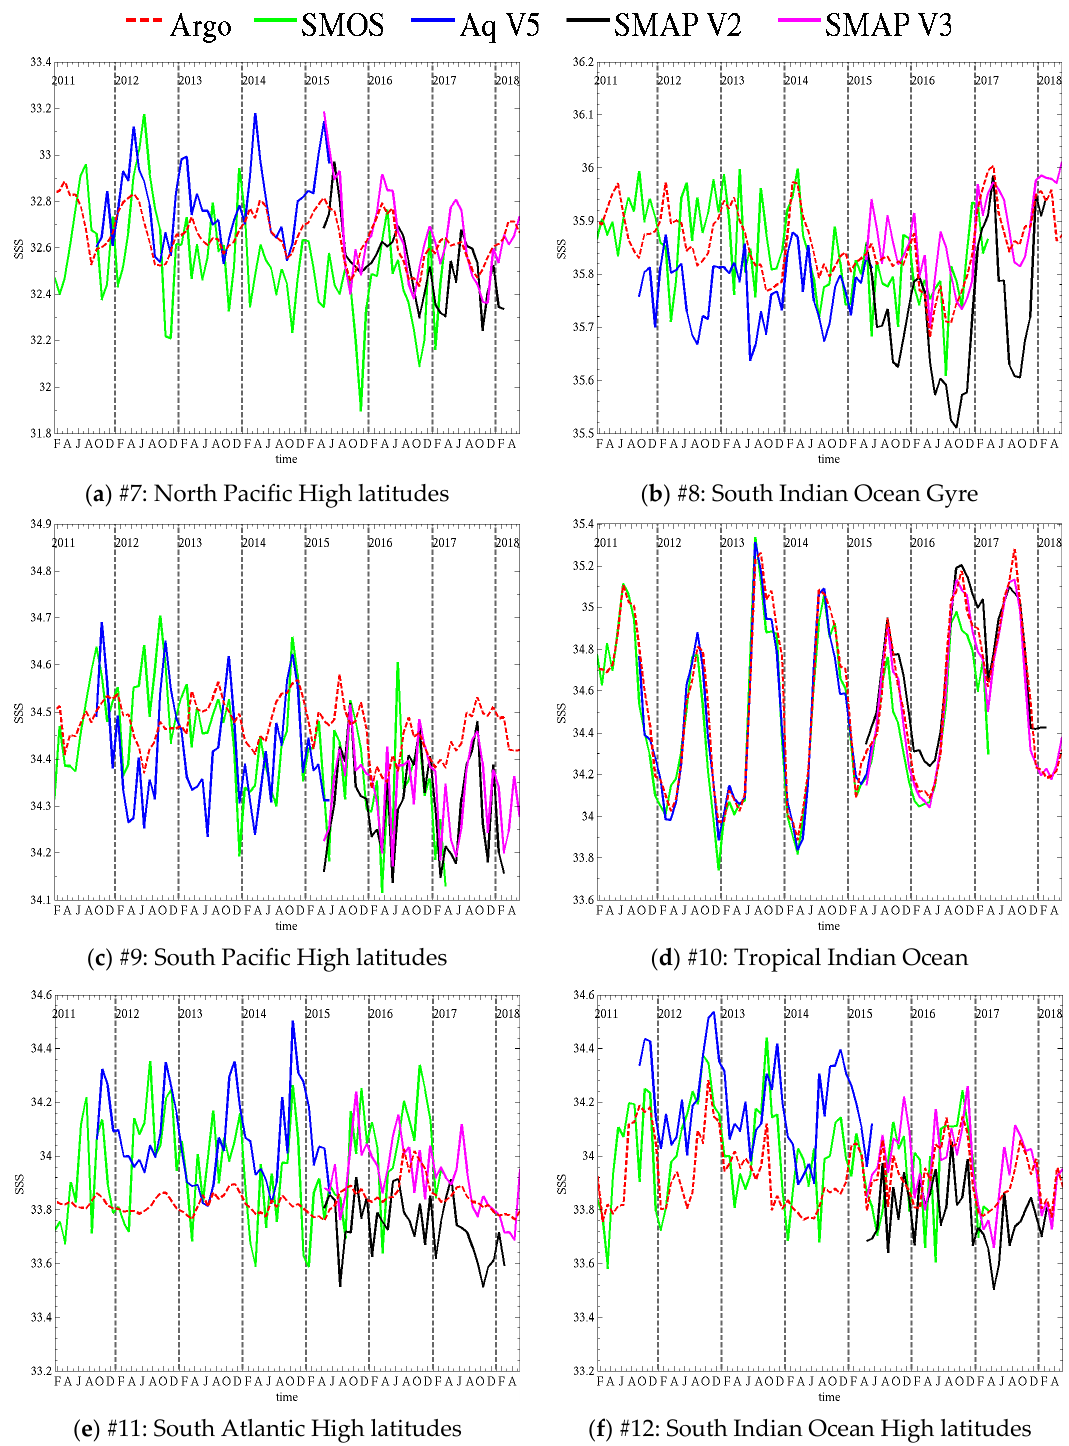
Figure 12. Time series of SSS from (red) Argo, (green) SMOS, (blue) Aquarius and (black) SMAP for regions of interest 1–6 reported in Figure 2.